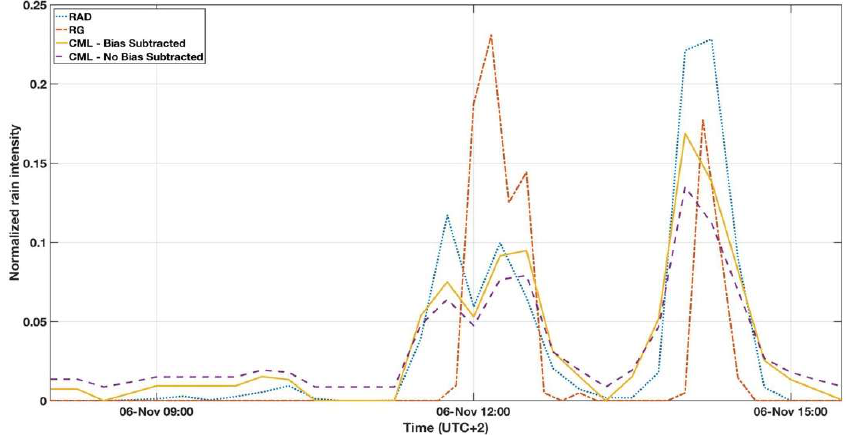
Figure 3. Normalized accumulated rain depth for a chosen event—25 January 2016 (event 4), monitored by: radar (RAD), rain gauges (RG-Arad and RG-Shani), and CML, with and without bias subtraction.